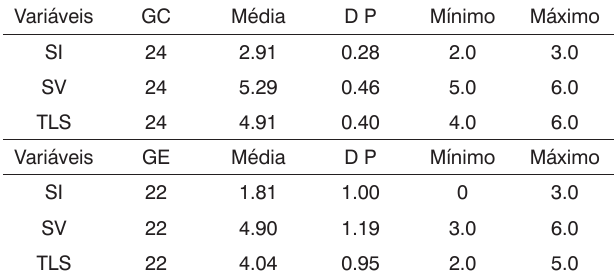
Tabela 3. Distribuição dos valores da Avaliação Simplificada do Processamento